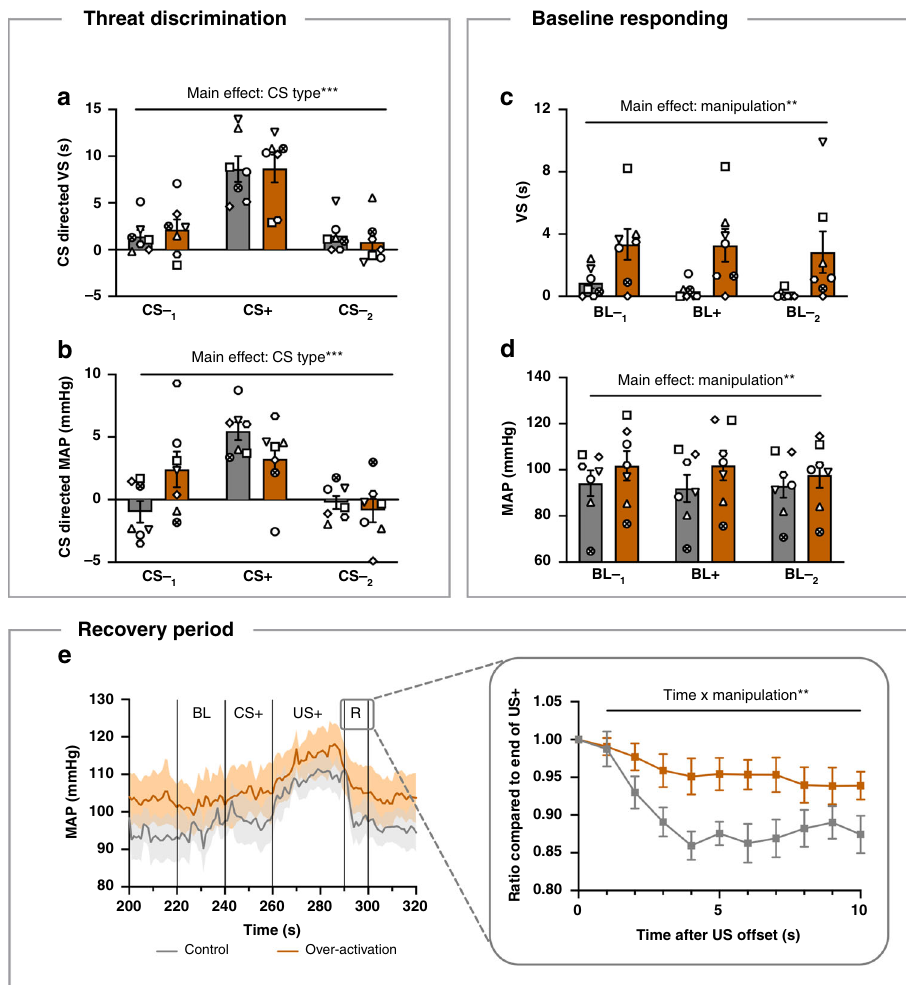
Fig. 4 Intact discrimination between threat and safety cues, but elevated baseline responding and slowed stress recovery, following sgACC/25 over- activation. Gray = control, orange = over-activation. Shading and error bars represent SEM. BL indicates baseline (20s pre-CS). n = 7. a sgACC/25 over- activation did not alter behavioral discrimination between safety (CS- 1 and CS- 2 ) cues and a threatening (CS + ) cue (two-way repeated measures ANOVA, manipulation × CS, F < 1, p = 0.647; main effect of CS type, F 2,12 = 32.3, p < 0.001, η 2 = 0.619). b There was a trend towards fl attening of the blood pressure (MAP) discrimination between safety cues and a threatening cue following over-activation (two-way repeated measures ANOVA, manipulation × CS, F = 3.8, p = 0.054; main effect of CS type, F = 19.5, p < 0.001, η 2 = 0.382). c sgACC/25 over-activation elevated baseline VS (two-way 2,12 2,12